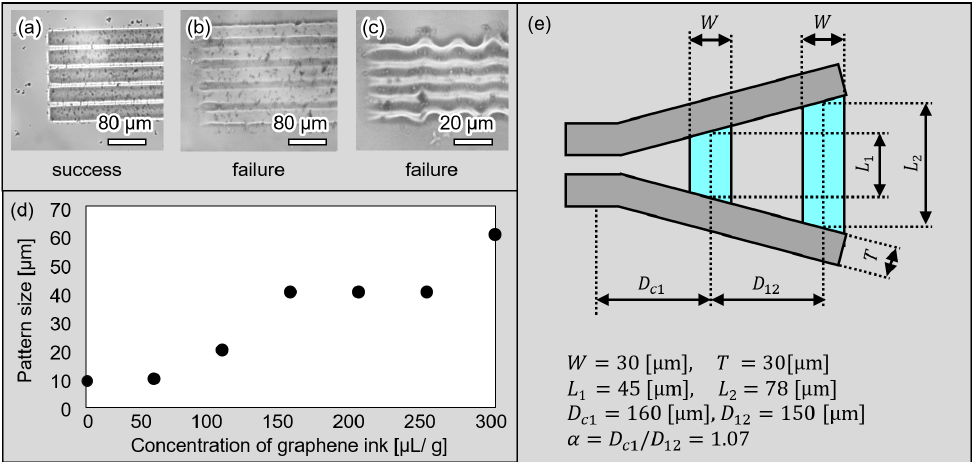
Figure 4. The minimum processable size and design of the microgripper. ( a – c ) Examples of the microscopic images of patterned gel actuator; ( d ) minimum processable size with various amounts of graphene ink; and ( e ) the design of the